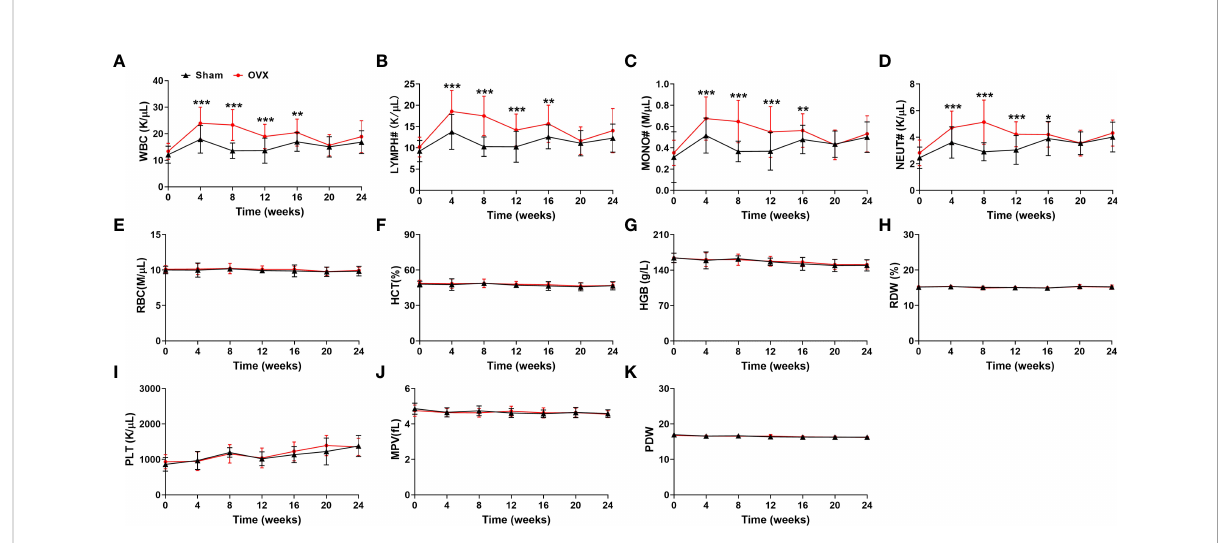
FIGURE 2 Analysis of hematological indices in estrogen de fi ciency-related osteoporotic mice. (A – K) The counts of WBC (A) , LYMPH# (B) , MONO# (C) , NEUT# (D) , RBC (E) , HCT (F) , HGB (G) , RDW (H) , PLT (I) , MPV (J) and PDW (K) in de fi ciency-related osteoporotic mice were examined by Hematology Analyzer. n = 32. * p <0.05, ** p <0.01, *** p <0.001 versus sham. Sham, sham operation group; OVX, ovariectomy operation group; WBC, white blood cells; LYMPH#, lymphocytes; MONO#, monocytes; NEUT#, neutrophils; RBC, red blood cells; HCT, hematocrit; HGB, hemoglobin; RDW, red cell distribution width; PLT, platelets; MPV, mean platelet volume; PDW, platelet distribution